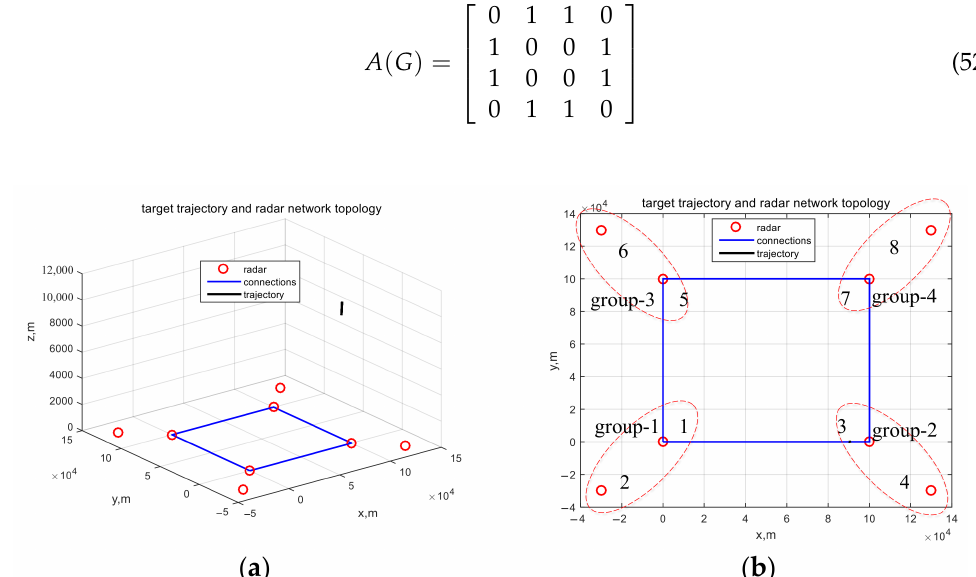
Figure 1. Simulation scene. ( a ) 3D. ( b )